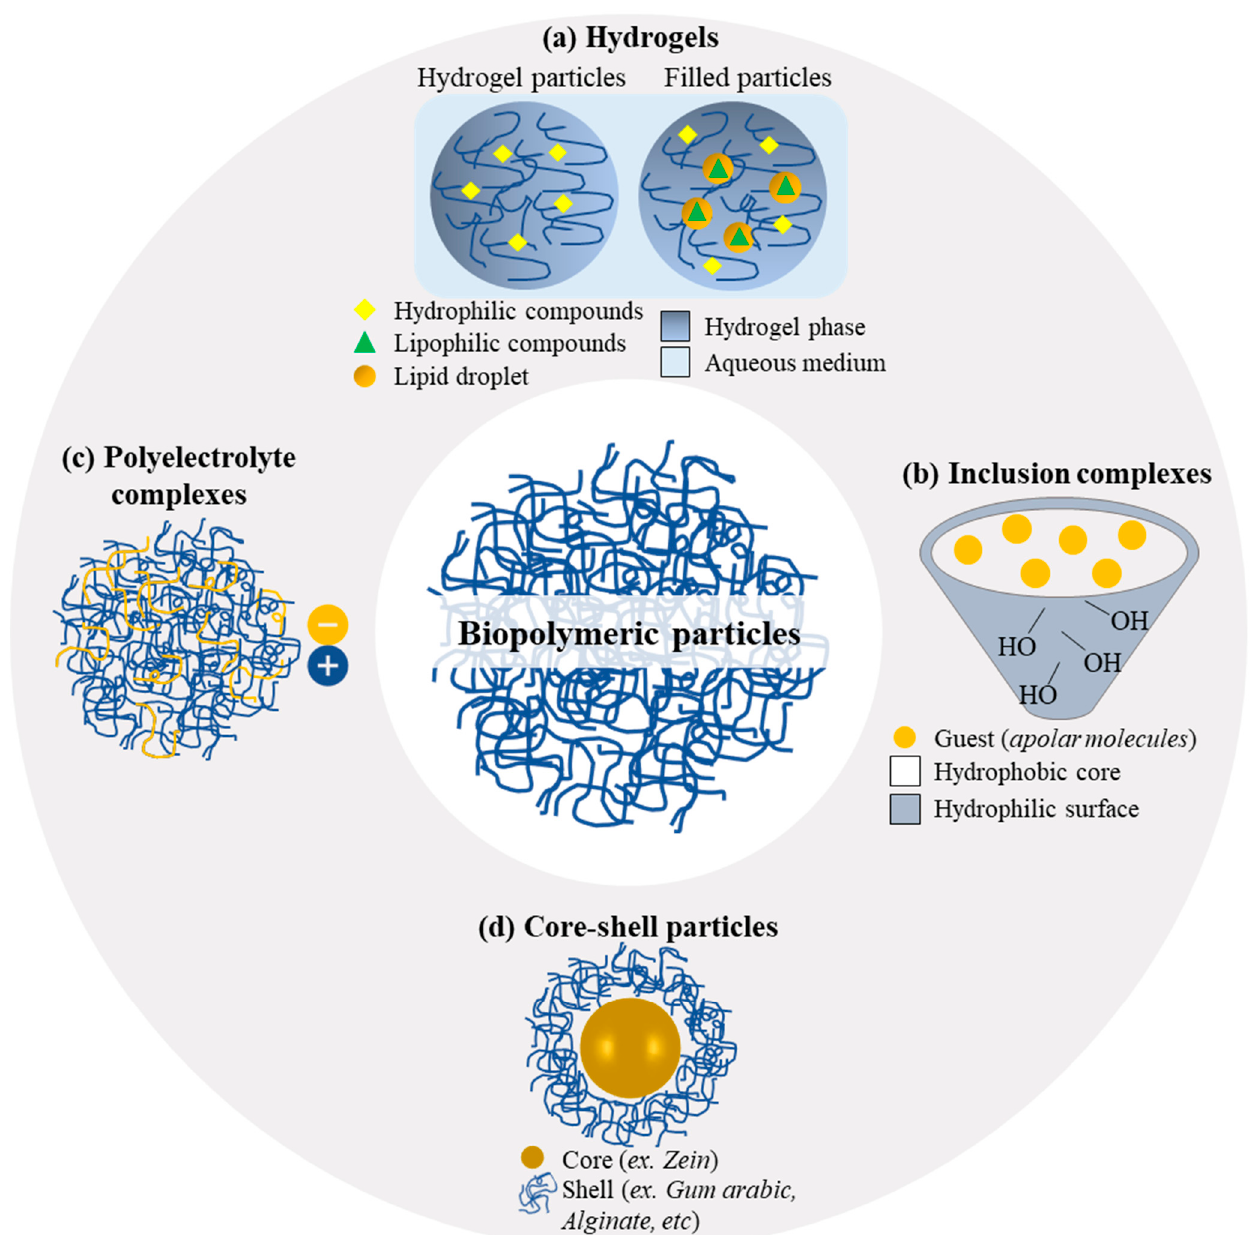
Figure 2. Main types of colloidal biopolymeric particles formed from natural or synthetic polymers.